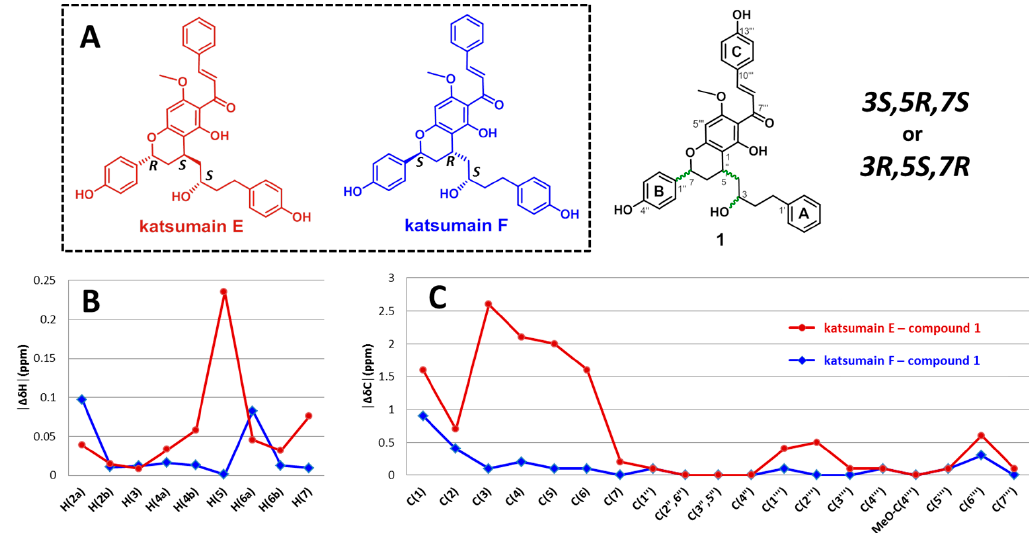
Figure 3. Comparison of 1 H ( B ) and 13 C ( C ) chemical shift differences between model compounds (katsumain E and katsumain F; A ) and compound 1 .